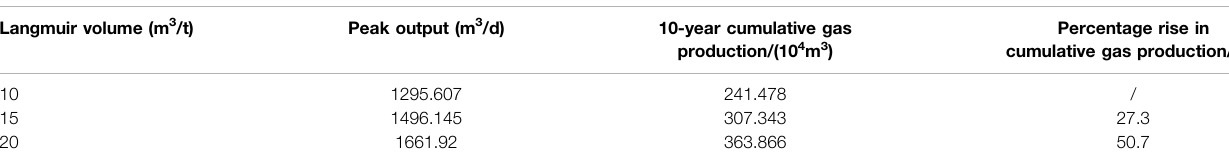
Table 5 . The peak output and cumulative output of CBM increase with rises in Langmuir pressure, but the margin of growth slows.